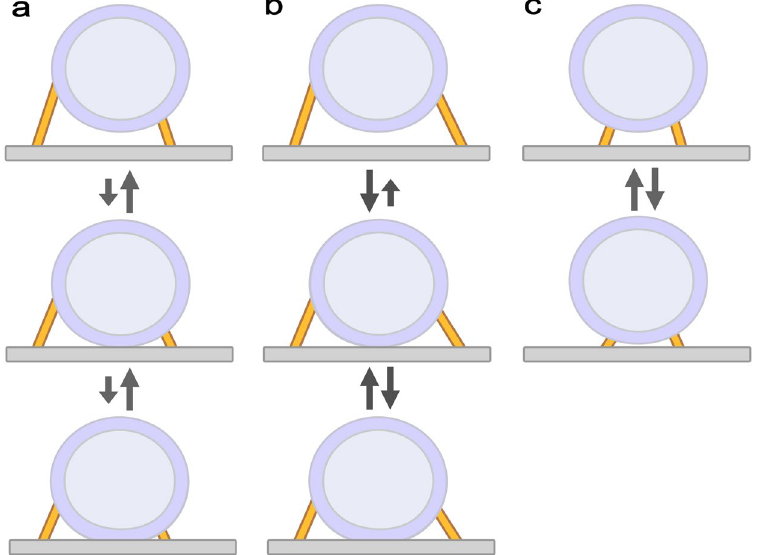
Figure 7. Schematic diagrams of the stochastic AZM mediated SV docking and priming model. Diagrams depict the transition of an SV between undocked and docked states based on the stochastic AZM-mediated SV docking and priming model. Multiple AZM macromolecules dock their associated SV onto the PM and prime it by shortening of the macromolecules, and the SV can be also undocked by lengthening of the macromolecules and repulsive forces between the vesicle membrane and the PM. ( a ) The AZM macromolecules are randomly attached to the hemisphere of the SV facing the PM. Their random distribution combined with their random shortening/lengthening results in moderate docking efficiency (~50%). ( b ) The AZM macromolecules are randomly attached to the upper half of the SV’s hemisphere. Their distribution combined with their random shortening/lengthening results in high docking efficiency (~100%). ( c ) The AZM macromolecules are randomly attached to the lower half of the SV’s hemisphere. Their distribution combined with their random shortening/ lengthening results in low docking efficiency